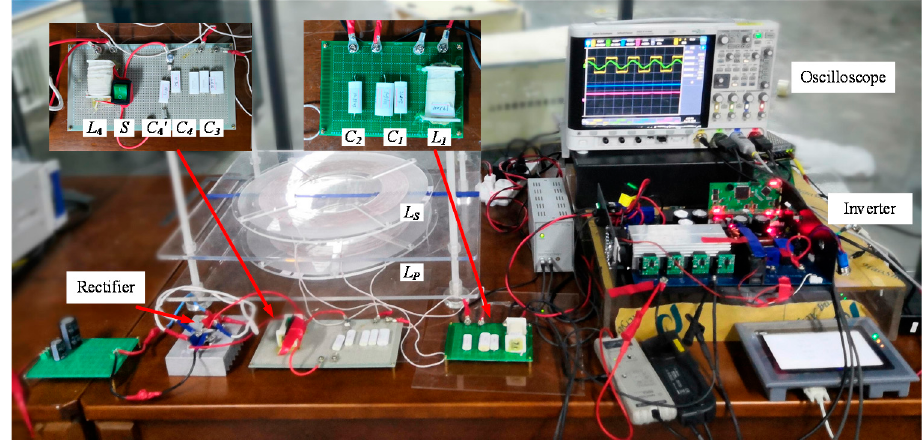
Figure 12. Prototype of the WPT charging system.